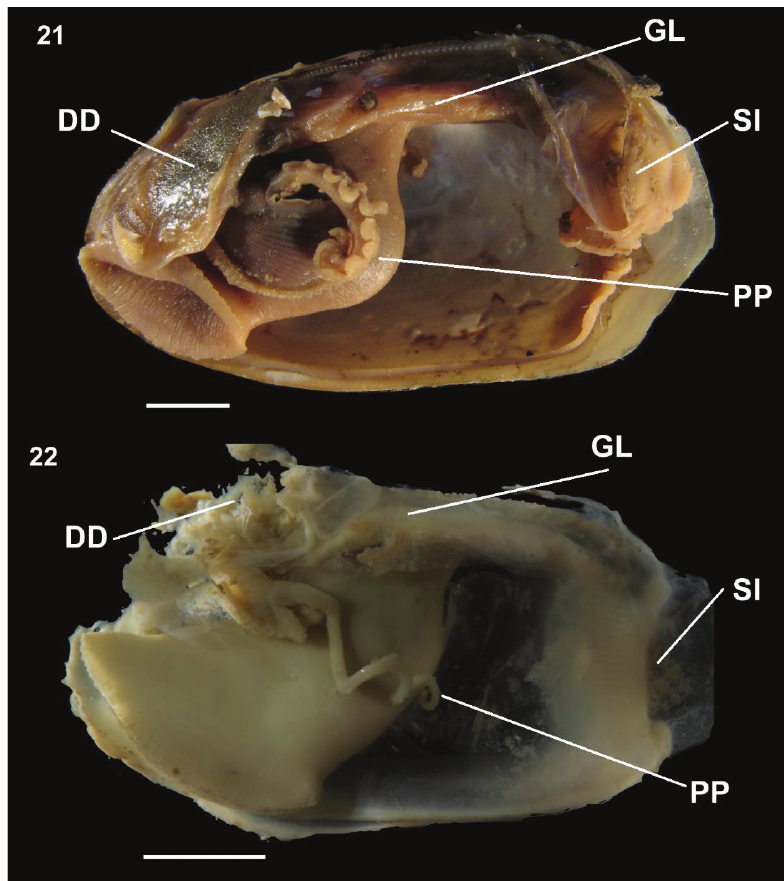
Figure 21–22. 21 Malletia alata (EMU7054) Gulf of California, Mexico, lateral view of anatomy 22 Malletia tumaquensis sp. n. Lateral view of anatomy. Scale bars: 0.5 mm. Abbreviations: DD Digestive diverticula, FT Foot, GL Gill, SI Siphon, PP Palp New location. Off Nariño, Colombian Pacific. Distribution. Sitka, Alaska, to Tumbes, Peru (Coan and Valentich-Scott 2012). Remarks. This material represents a new record for the Colombian Pacific.